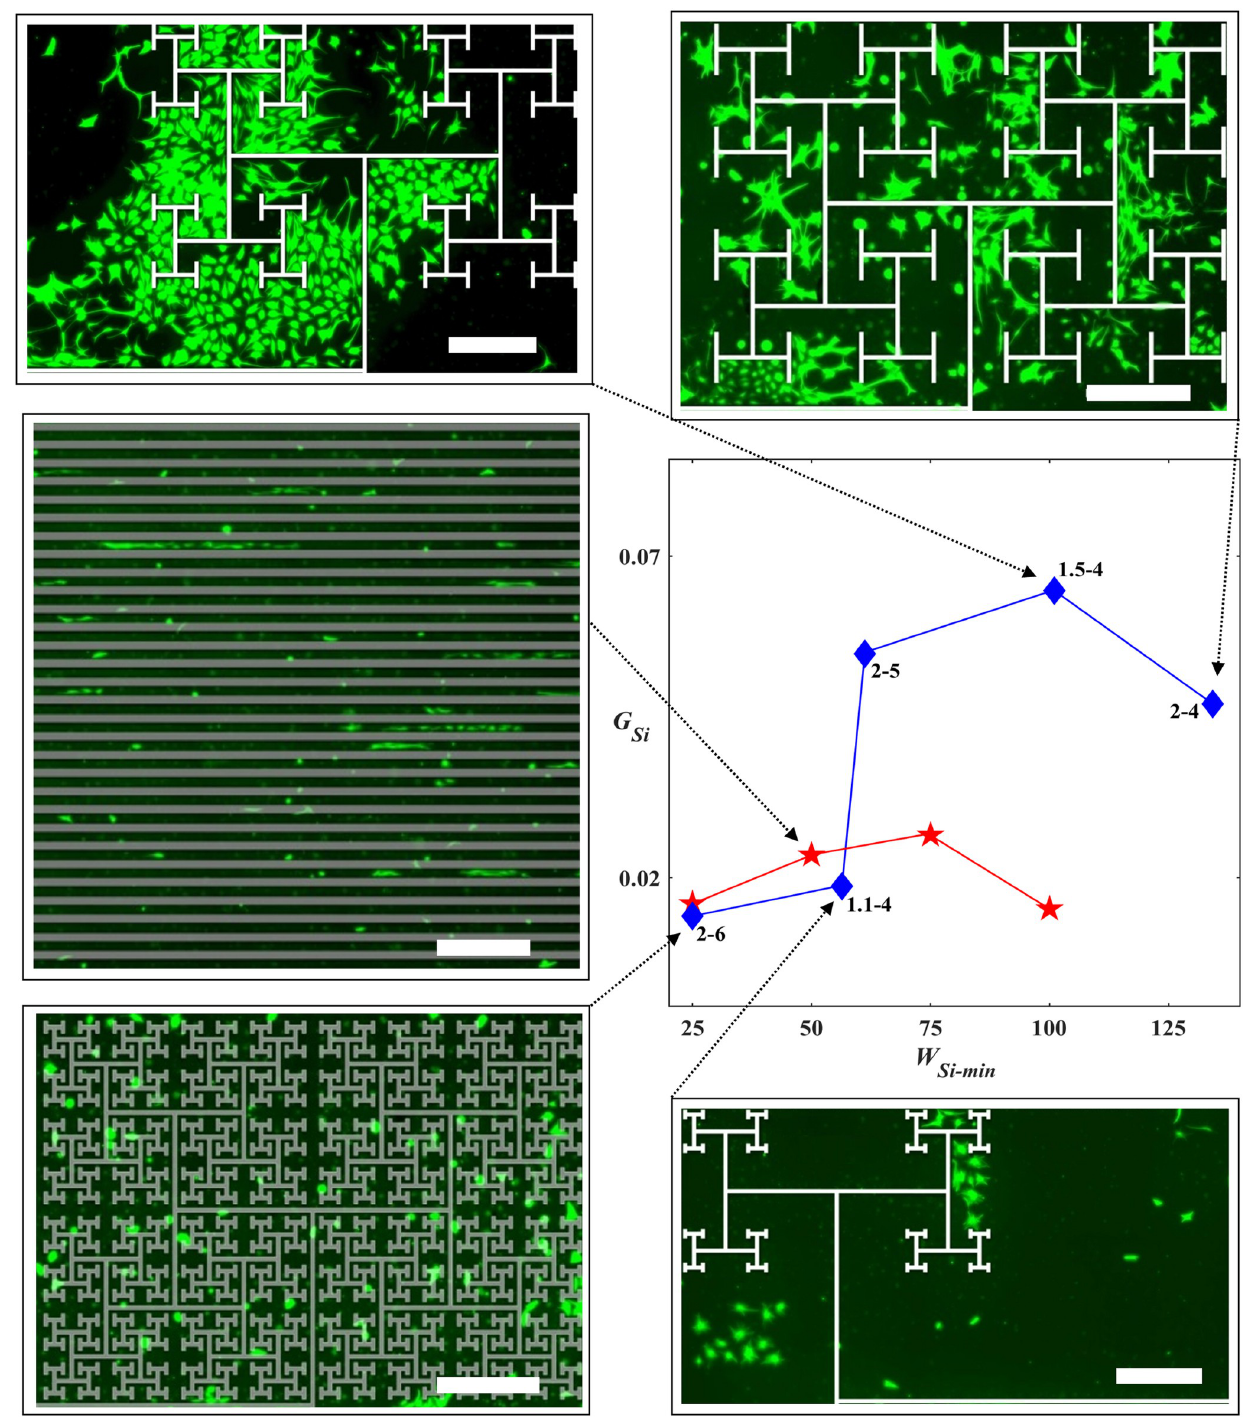
Fig 8. Glial behavior on SiO 2 surfaces. Fluorescence images of glial cells (green) at 17 DIV are shown for zoom-in sections showing 1/4th of the full electrode images for the 1.1–4 (bottom right), 1.5–4 (top left), 2–4 (top right), and 2–6 (bottom left) fractals along with the S50C50 (middle left) Euclidean electrodes. White or gray masks are imposed on to the fluorescence images to indicate the locations of the electrodes. Scale bars are 500 μ m. A plot of G Si median change against W is also shown. The dashed arrows connect the images to their corresponding datapoints in the plot. The blue diamond Si-min symbols represent fractals. The red pentagrams represent the 17 DIV Euclidean electrodes grouped based on their W Si . The error bars correspond to the 95% confidence intervals and are excluded for visual simplicity but range from ± 8 × 10 − 3 (for W = 100 μ m) to ± 4 × 10 − 2 (for 1.5–4). The significance Si-min results (see text) are also excluded for